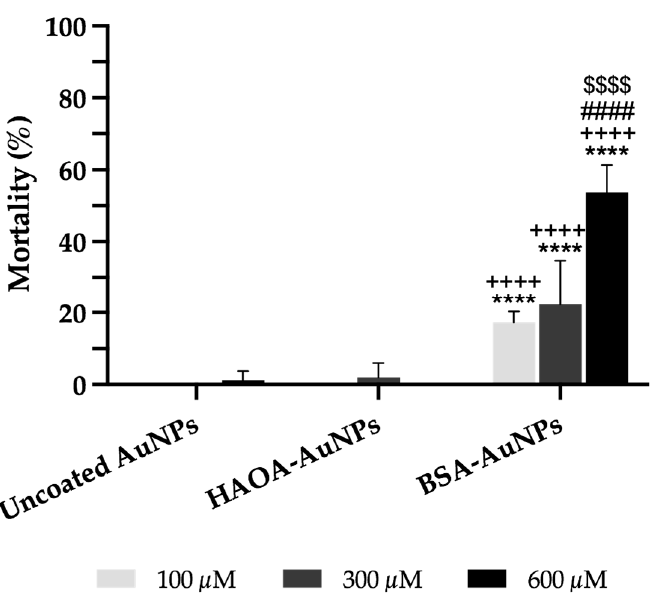
Figure 7. Mortality (%) of Artemia salina 24 h after incubation with uncoated AuNPs, HAOA-AuNPs and BSA-AuNPs at three di ff erent concentrations (100, 300 and 600 µM). Artemia salt medium and 100% of DMSO were used as negative control and positive control, respectively (not shown in the graphic). Data are presented as mean value ± SD, n ≥ 4. Two-way analysis of variance (ANOVA), Dunne tt ’s and Tukey’s tests ( p < 0.05), were used to detect di ff erences between the groups. **** p < 0.0001 vs. uncoated AuNPs at same concentration; ++++ p < 0.0001 vs. HAOA-AuNPs at same concentration; #### p < 0.0001 vs. the respective formulation at 100 µM; $$$$ p < 0.0001 vs. the respective formulation at 300 µM.